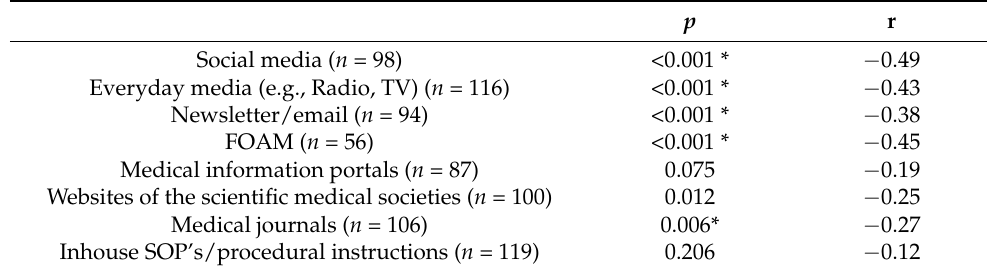
Table 3. Group differences in quality assessment of information sources between users and non-users (Mann-Whitney-U-Test).